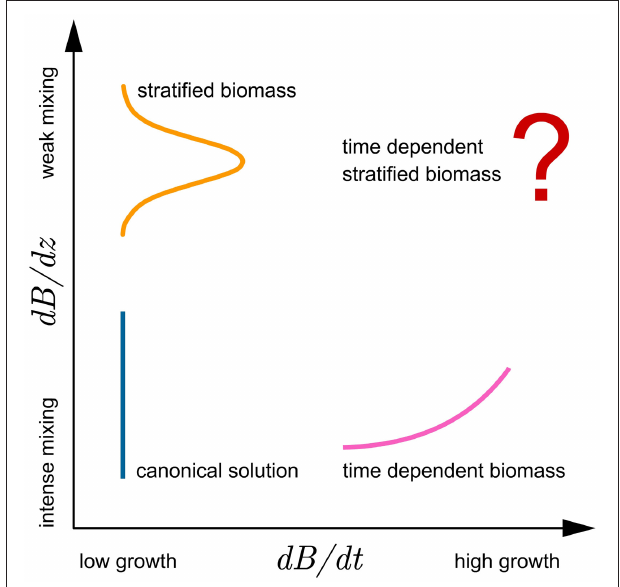
Frontiers in Marine Science |